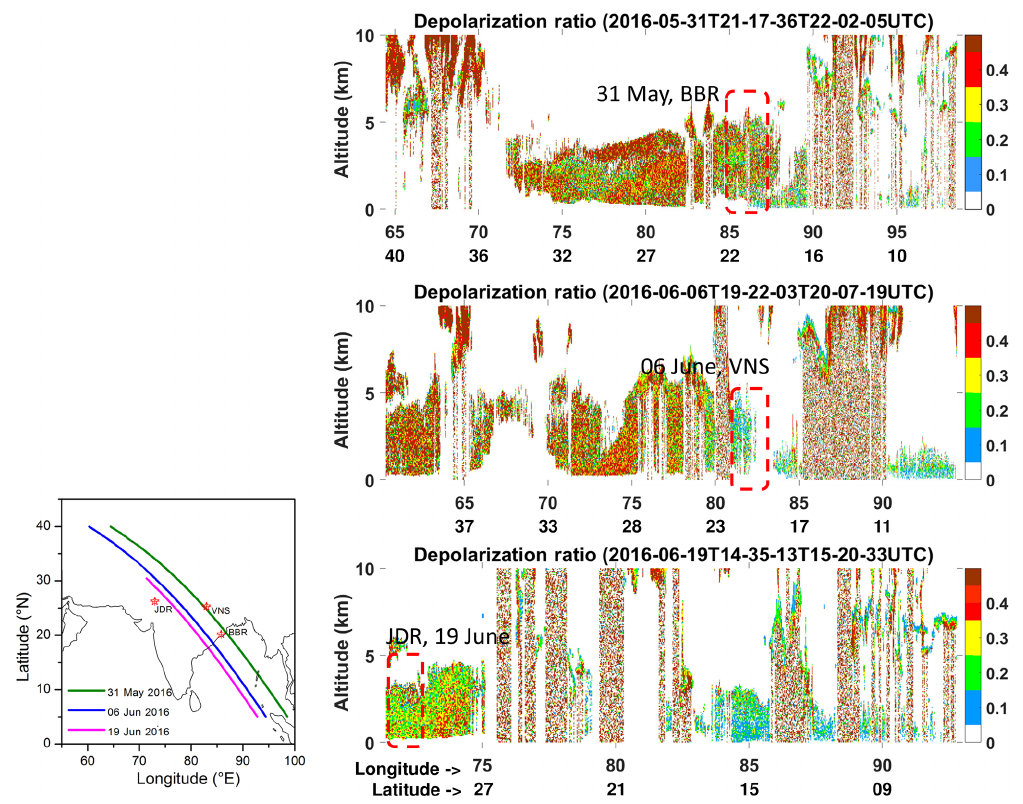
Figure 9. Aerosol depolarization ratio (obtained from Cloud-Aerosol Transport System (CATS) on the International Space Station, ISS) for three different passes of the ISS over the three subregions during the period of aircraft observation. The tracks of CATS are shown by the solid lines in the left panel, and the rectangular boxes in the right panels show the data over the subregions.